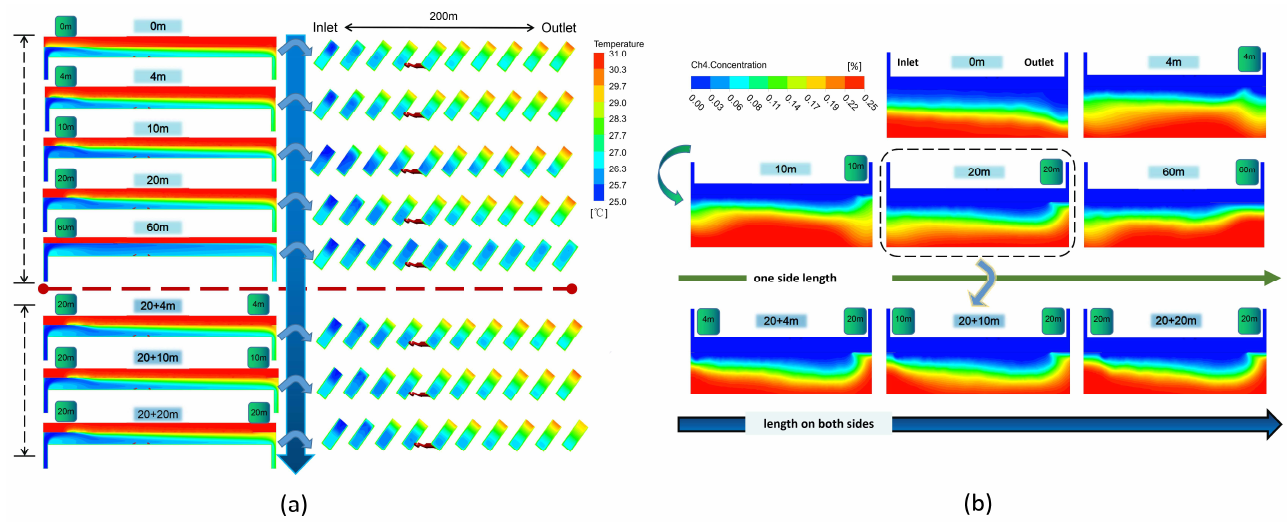
Figure 9. Distribution of working face temperature and gas concentration with different air curtain arrangements. ( a ) Temperature distribution map; ( b ) Gas concentration distribution map.